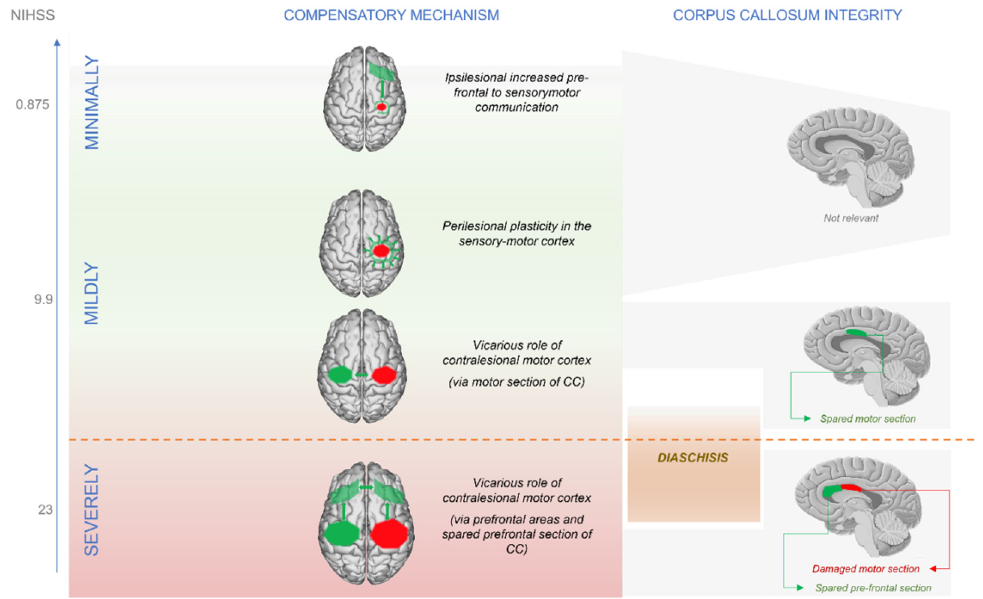
Figure 1. Patients lie on a continuum of severity. Minimally affected patients resolve the competition within the ipsilesional hemisphere. Going towards the more affected patients, the contralesional hemisphere becomes more and more relevant in compensatory processes. The process of diaschisis start playing role in more severe-like mildly affected patients.